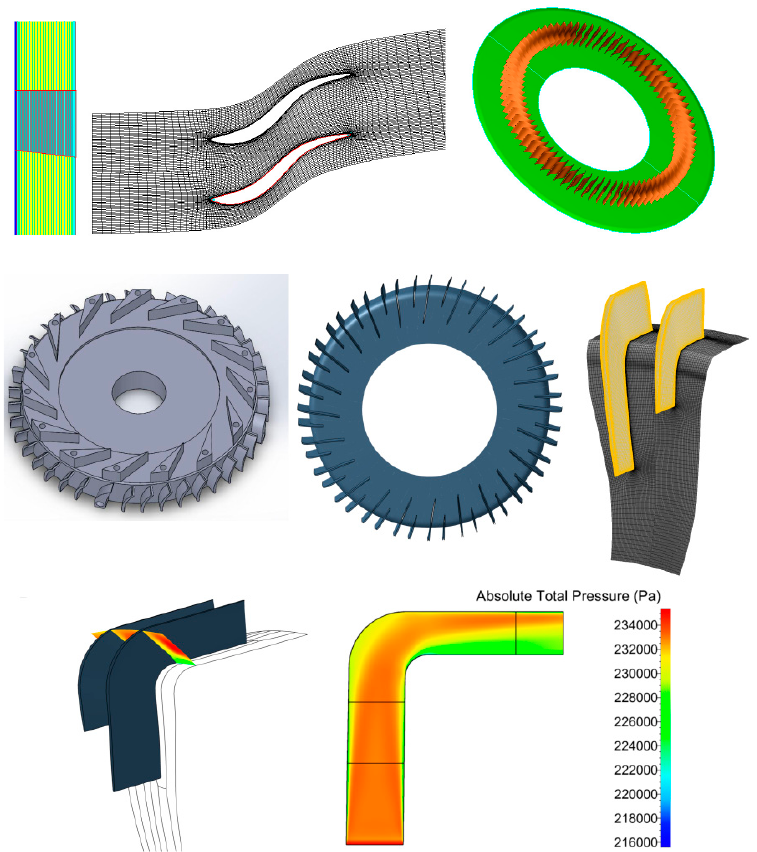
Figure 30. Curved leading edge design with few parameters, radial de ‐ swirler vane, and a redesign of radial diffuser for JetCAT P90